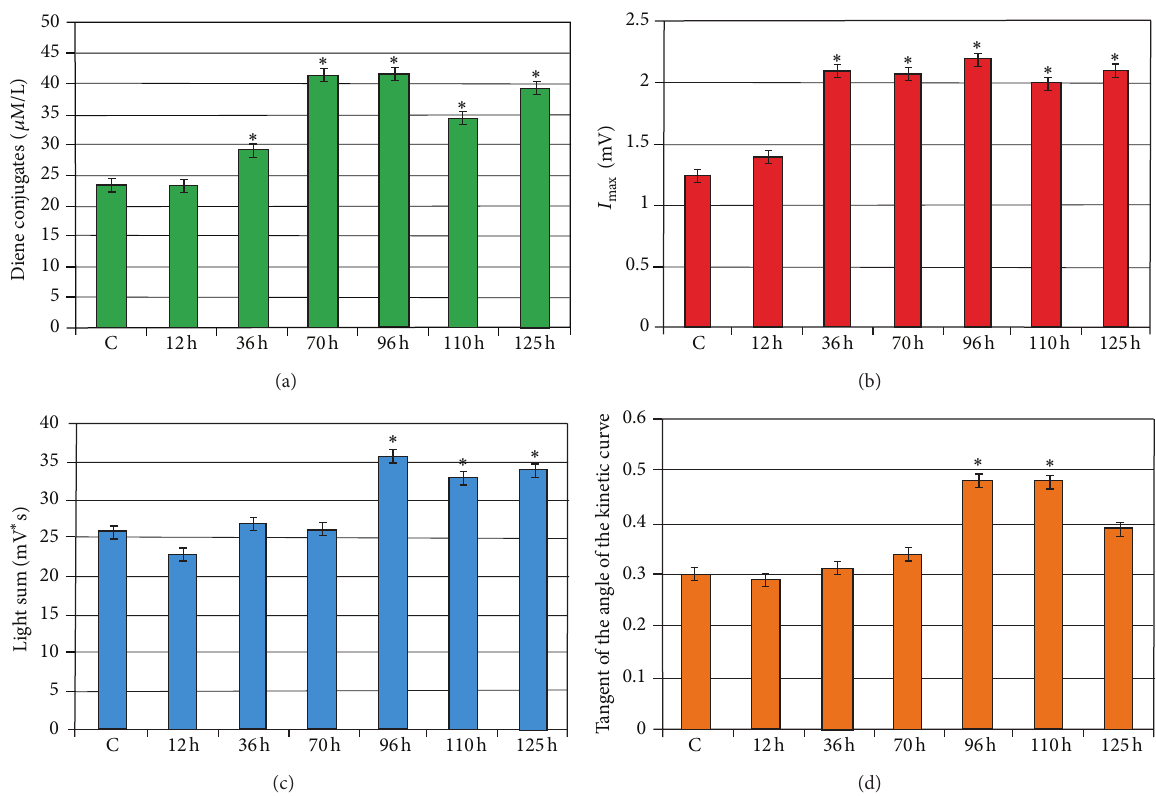
Figure 2: The content of diene conjugates and parameters of biochemiluminescence in rat liver during the development of experimental toxic hepatitis: (a) content of diene conjugates (umol/L). (b) Maximum flash intensity (Imax, mV). (c) Light sum, mV ∗ c. (d) Tangent of the angle of the kinetic curve. Compared with control: ∗ 𝑃 < 0.05 .